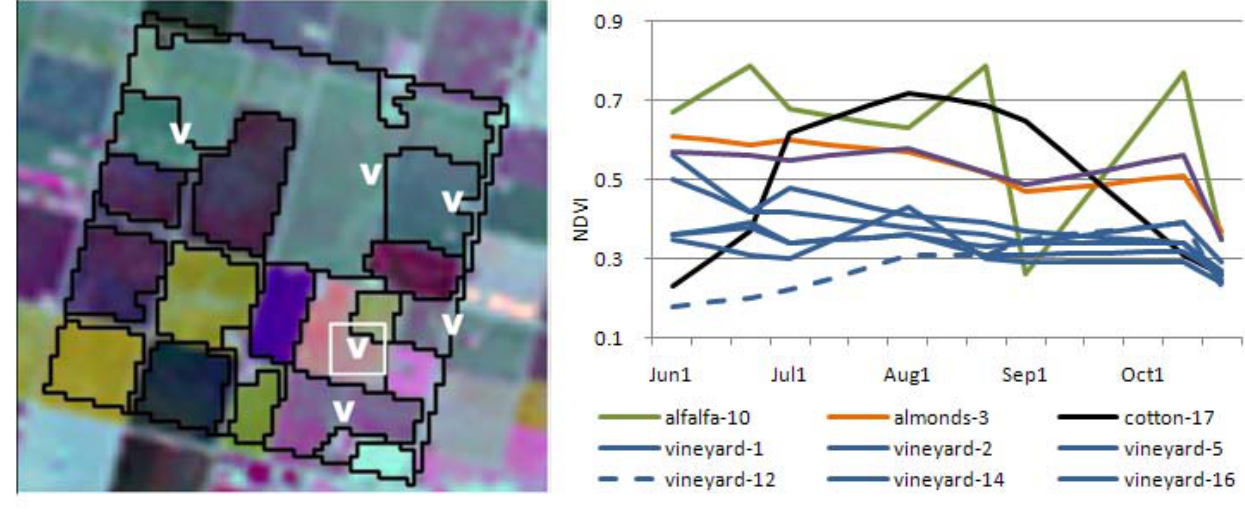
Figure 3. Landsat time series color composite image (left, PCA123) and Normalized Difference Vegetation Index (NDVI) time series plots (right) for selected crop fields within Section 14S17E01. Paraquat was applied to two vineyard fields. Five of the six field units (identified as a white “V” on the image and blue lines in the graph) identified as vineyard on the California Department of Water Resources (CDWR) map had NDVI time series closely matching vineyard library signatures (median ≤ 0.09). One field unit identified as vineyard on the CDWR map appeared to be newly planted (white “V” inside of white box). The difference value was greater for this field (0.17) because the library did not contain signatures for newly planted vineyards. Identification of the specific two fields that were sprayed with paraquat was not possible in this example because more than two fields were identified as vineyards within the